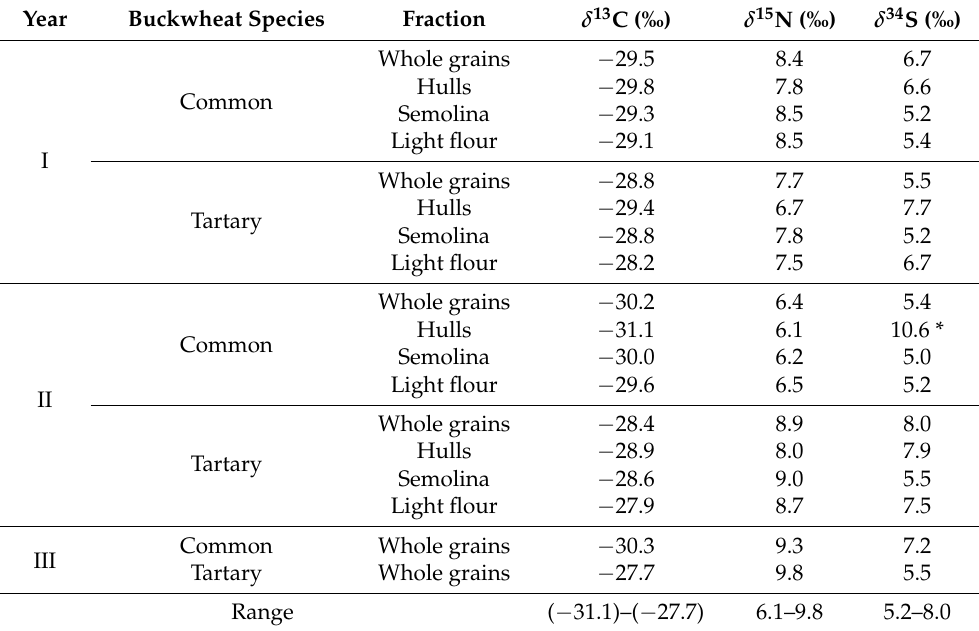
Table 1. The isotopic signature of whole grains and milling fractions (hulls, semolina, and light flour) of common and Tartary buckwheat individual samples harvested during